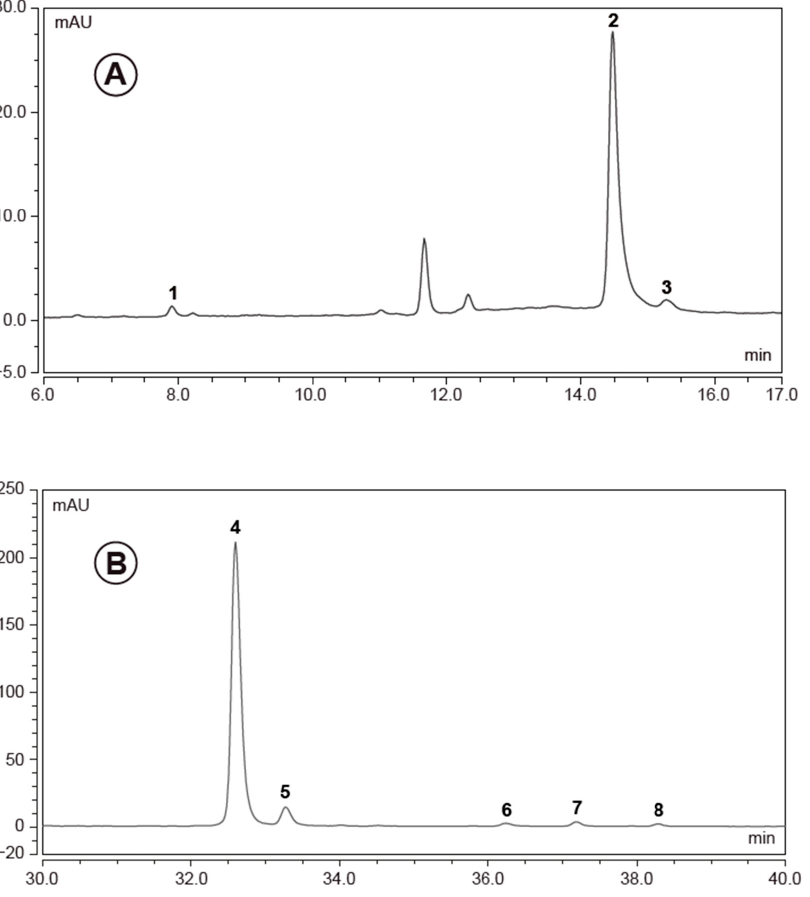
Figure 2. The HPLC chromatogram of phenolic compounds in EC 3.2. ( A ): peak 1: neochlorogenic acid; peak 2: chlorogenic acid; peak 3: cryptochlorogenic acid. ( B ): peak 4: rutin; peak 5: isoquercitrin; peak 6: kaempferol-3-rutinoside; peak 7: isorhamnetin-3-rutinoside; peak 8: isorhamnetin-3-glucoside.